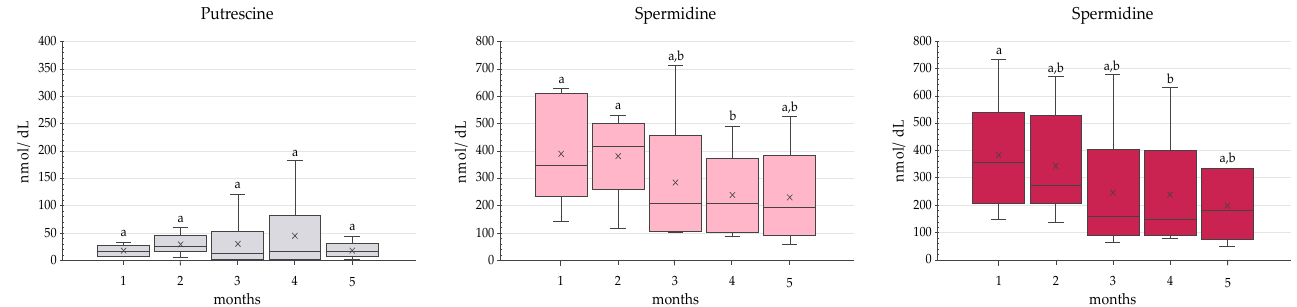
Figure 1. Distribution of total polyamine levels (nmol/dL) in human milk samples ( n = 6) during the first five months of breastfeeding. The bottom and top of each box (interquartile range) are the 25th and 75th percentiles, respectively. The central line represents the median and X represents the mean. Lines extending vertically from the boxes (whiskers) indicate variability outside the interquartile range. The red line represents the evolution of mean polyamine content during the first semester of breastfeeding. The Friedman test with Wilcoxon post hoc were used to compare the total polyamine contents during the breastfeeding process. Different letters indicate statistically significant differences between breastfeeding months (1 vs. 4 months, p = 0.016 and 2 vs. 4 months, p = 0.016).